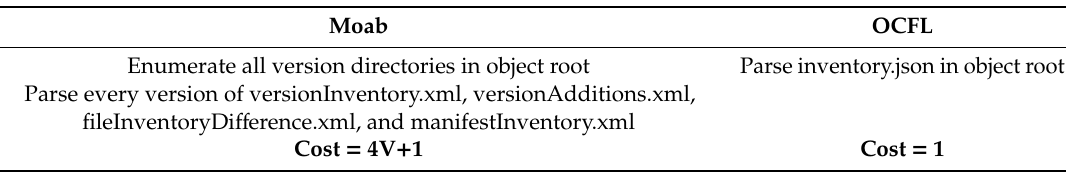
Table 2. Cost in filesystem calls to reconstruct full history of an